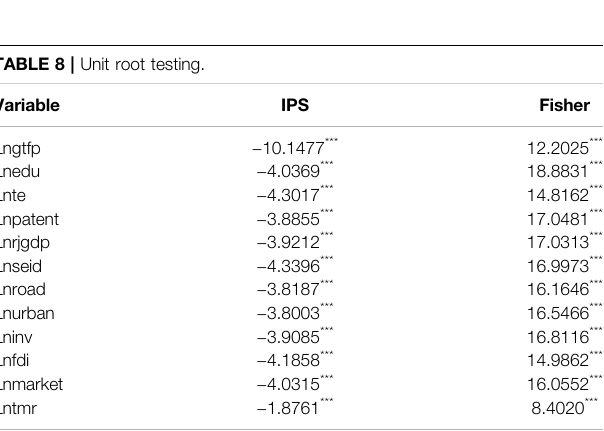
TABLE 8 | Unit root